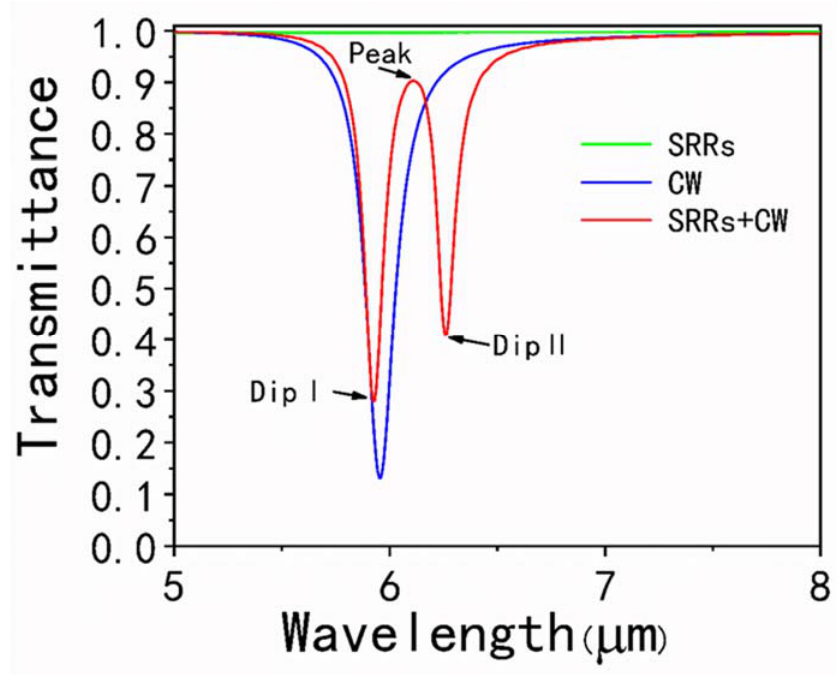
Figure 2. Transmission spectra of the individual graphene CW resonator, the individual graphene SRRs and the plasmonically induced transparency (PIT) metasurface consisting of the two resonators under x-polarized incident light excitation, respectively.